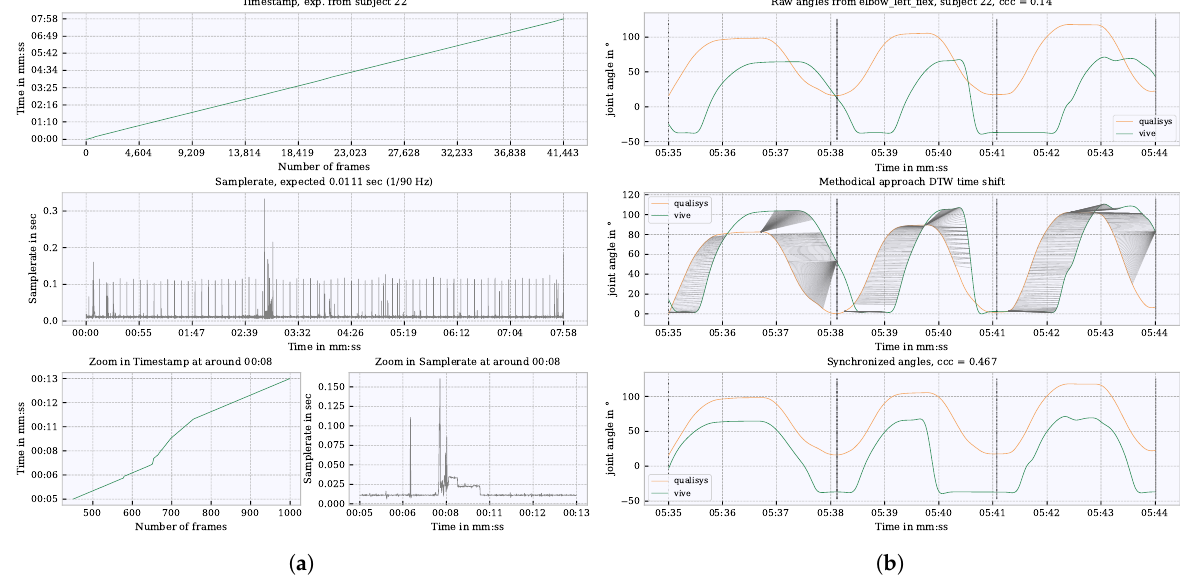
Figure 7. Cause of the occurring time shifts and demonstration of resynchronization. ( a ) Sample rate irregularities when recording kinematic data with Vive over an entire measurement per subject for a longer times series and zoomed in. ( b ) Representation of a time shift between Vive and Qualisys, and the synchronization approach based on DTW; black dotted vertical lines show the segment boundaries of a